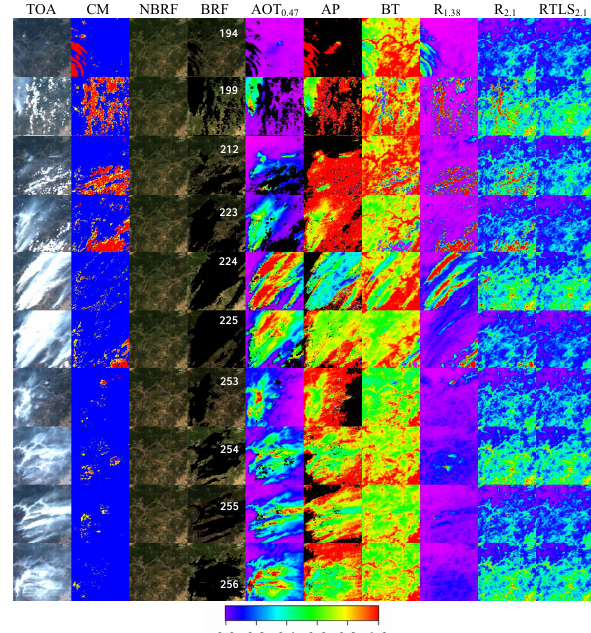
Figure 3 . Illustration of MAIAC algorithm performance for case of forest wildfires in Pacific Northwest, Rocky Mountains, USA, 2007. The images show MODIS Aqua RGB TOA data, MAIAC cloud mask (CM), RGB NBRF and BRF, AOT 0.47 , absorption parameter (AP), brightness temperature (BT), reflectance in MODIS cirrus channel (1.38 μ m), and measured and predicted, using retrieved BRDF model, reflectance in B7 (2.1 μ m). The results are shown for 150 km tiles for days of year from 194 to 256, as indicated in the 4th column. The blue color of the cloud mask correspond to clear pixels, and red-yellow show detected clouds. The following scales were used for columns 5-10 (based on displayed rainbow palette): 0-3 (AOT 0.47 ), 0.7-0.91 (AP), 273-305 (BT), 0-0.035 (R 1.38 ), 0-0.3 (R 2.1 and RTLS 2.1 ).